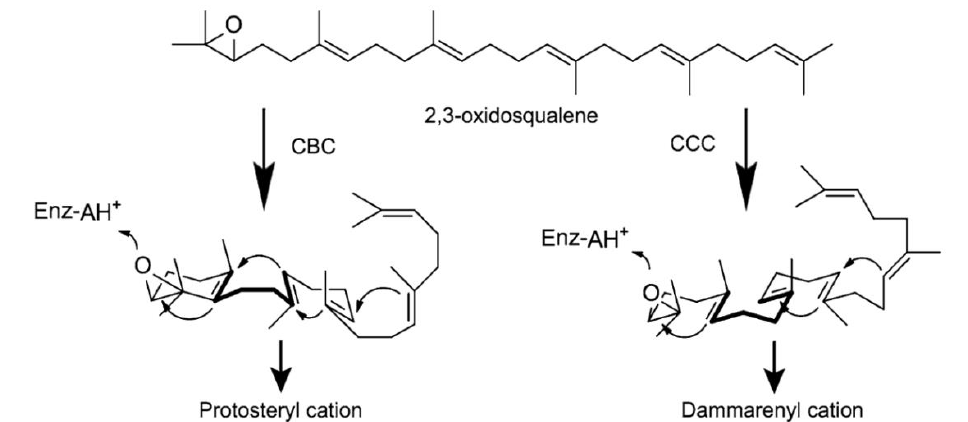
Figure A1. Two substrate prefolding types during the initial oxidosqualene cyclization reactions.